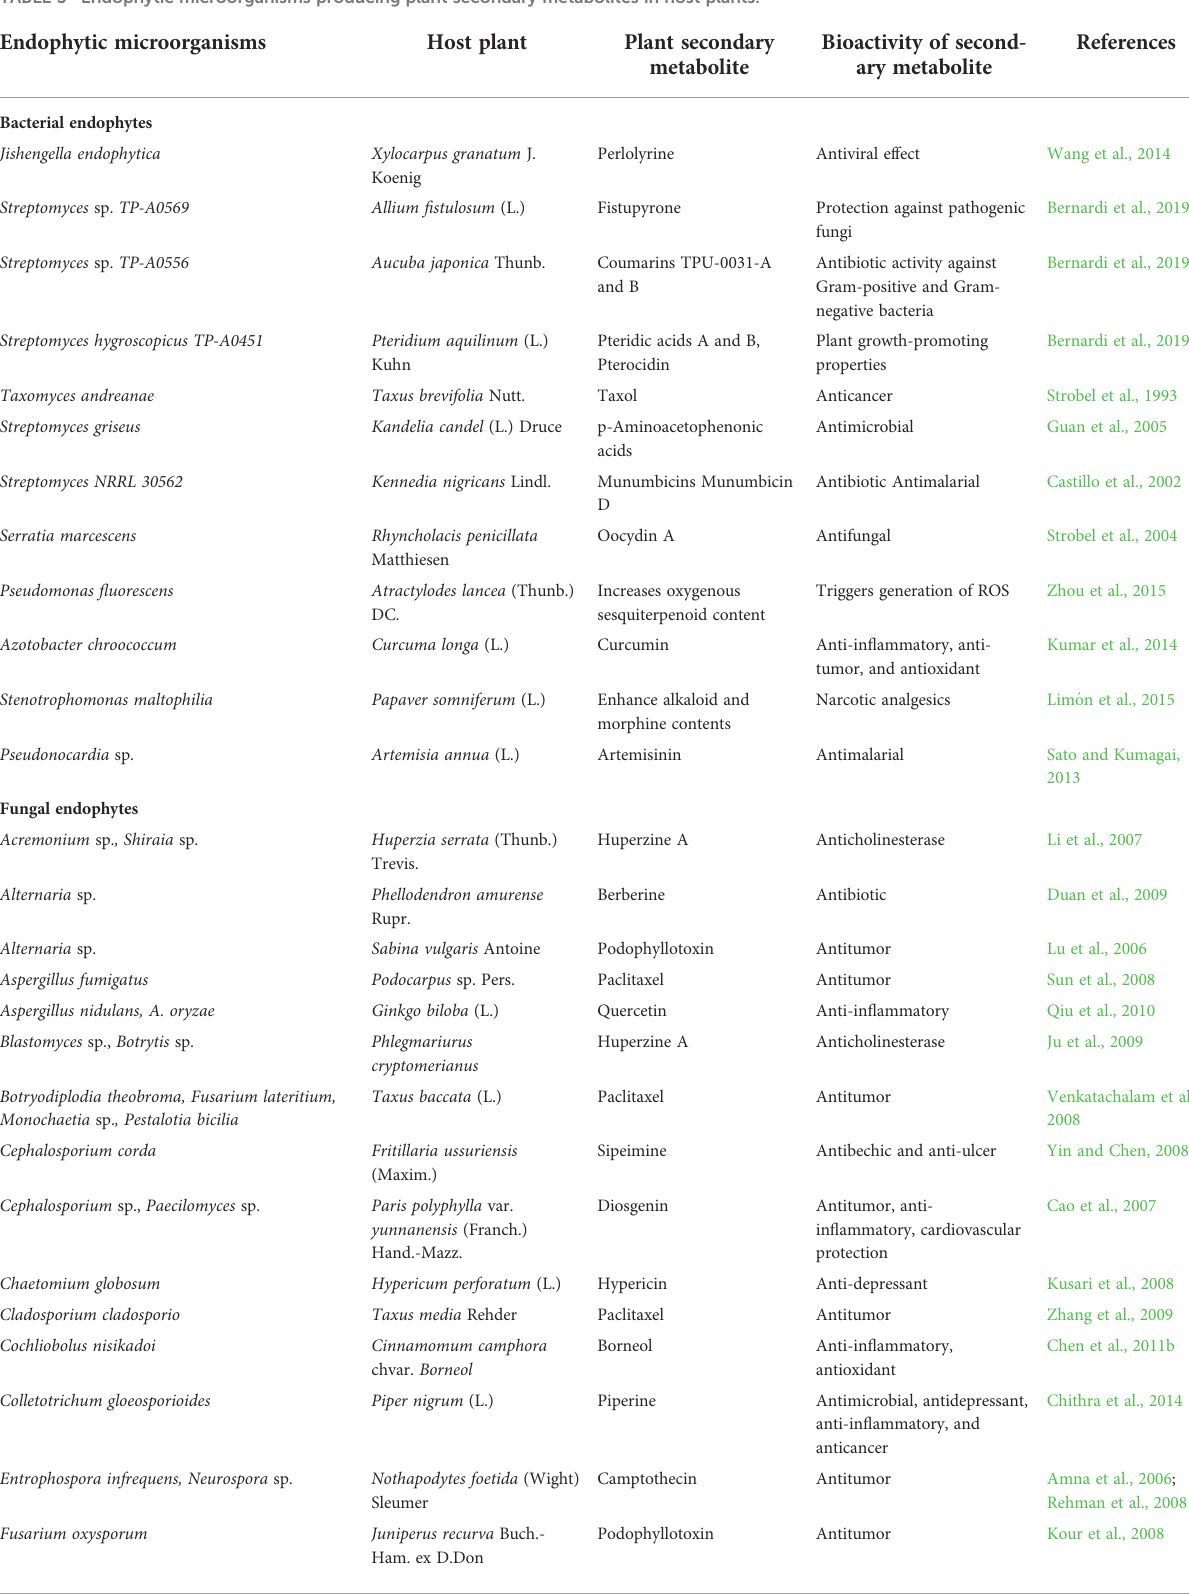
TABLE 3 Endophytic microorganisms producing plant secondary metabolites in host